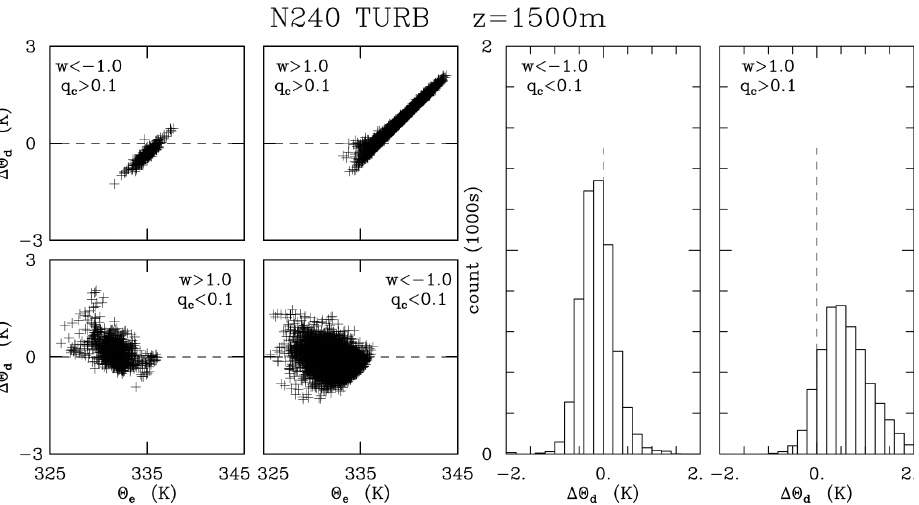
Figure 2. Left four panels: scatterplots of (cid:49)θ d vs. θ e for points at height of 1500m separated into different regions depending on the vertical velocity w and cloud water mixing ratio q c . Right two panels: histograms of (cid:49)θ d for points corresponding to cloud-edge downdrafts and cloud updrafts applying 0.2K bins. Results for N240 TURB simulation at 1500m